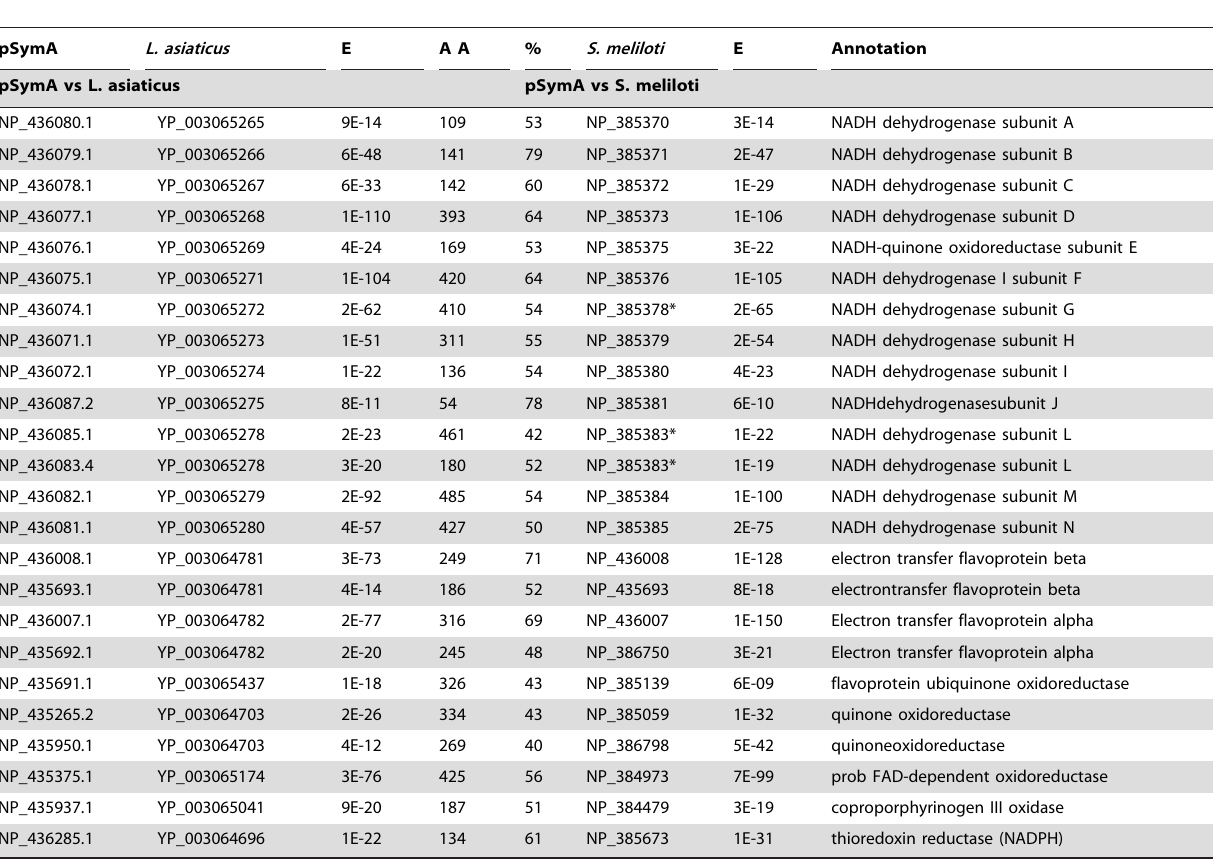
Table 5. Proteins shared between the Sinorhizobium meliloti plasmid pSymA, and the ‘ Ca . Liberibacter asiaticus’ and Sinorhizobium meliloti chromosomes with roles in electron